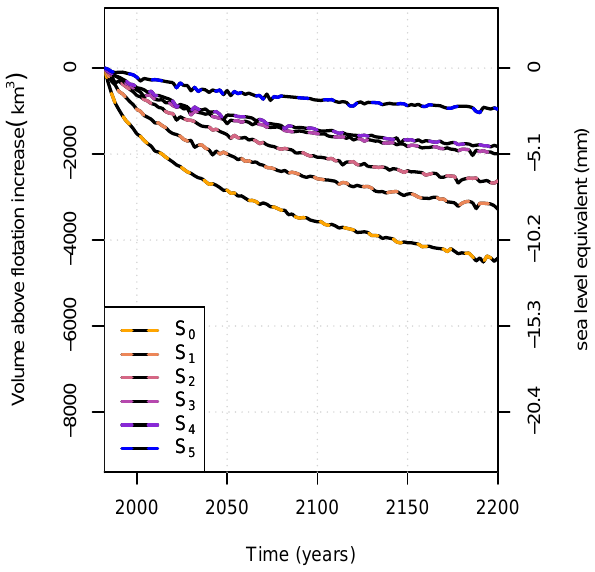
Figure 10. Evolution of the volume above flotation due to extreme forcing. All of the extreme sensitivity experiments result in loss of grounded ice, from 1mm sea level rise for experiment S 5 to 11mm for experiment S 0 . Experiment S 3 removes 2500km 2 more from the ice shelf than S 4 , yet the two experiments show the same trend in volume above flotation (3mm sea level rise by 2200). Experiment S 2 removes a further 2500km 2 , from around Clemence massif, to much greater effect